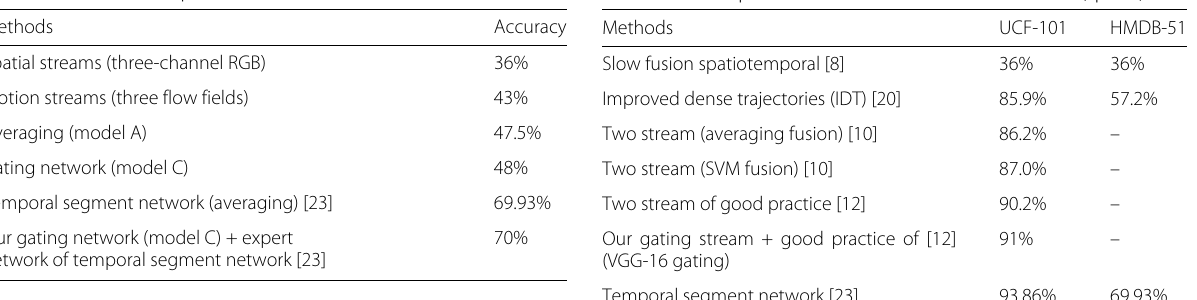
Table 13 Comparison with state-of-the-art methods (split